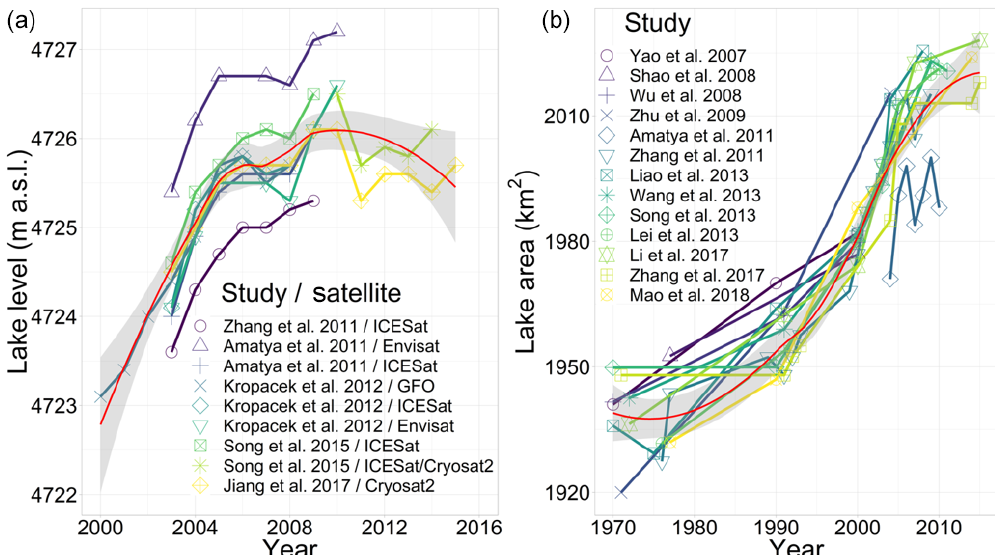
Figure 3. (a) Lake level changes of Nam Co since 2000 (there is notable shift in the water balance in 2009), and (b) changes of the lake surface area since 1970, as evaluated in previous studies. The overall increase rate of lake area is 2.1km 2 yr − 1 . Red lines denote LOESS curves, with the 95% confidence interval shown in